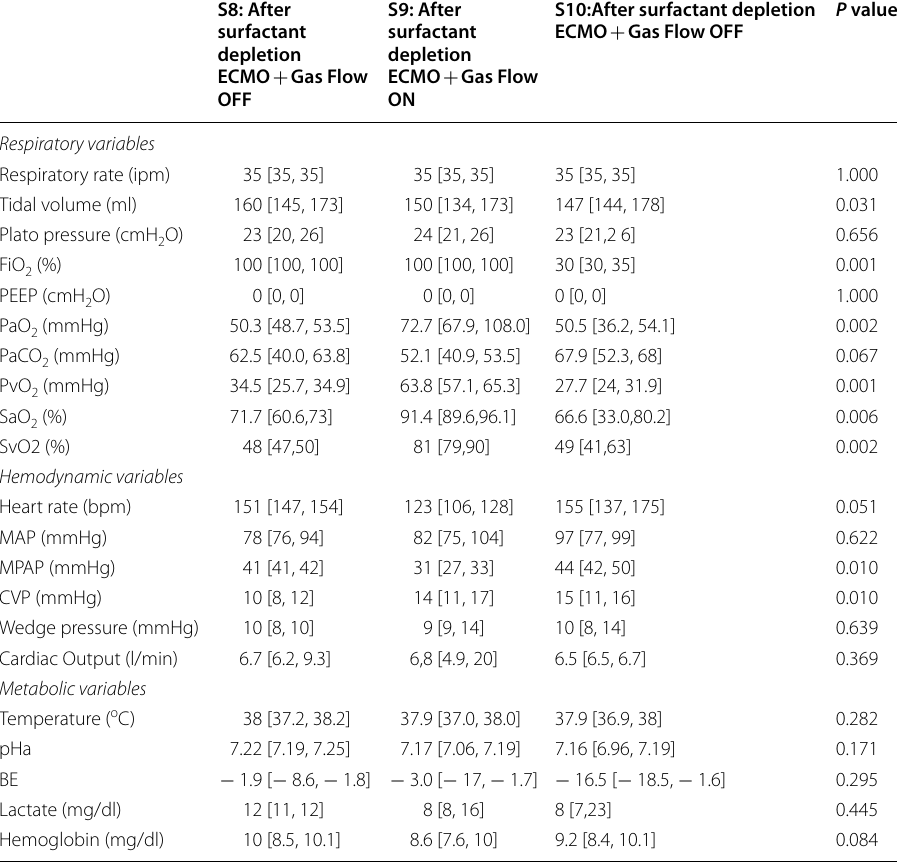
Table 2 Comparison between stages 8 (S8), 9 (S9) and 10 (S10), that is, variables with and without ECMO support after lung